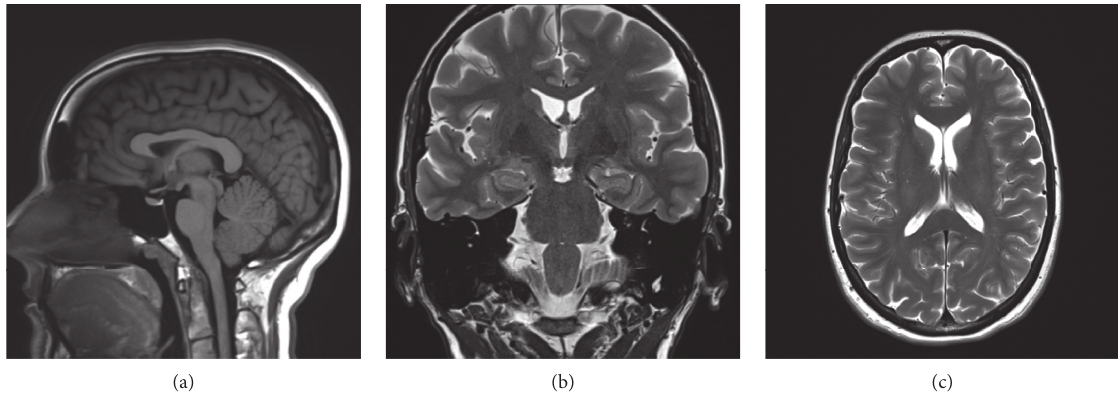
Figure 1: Brain MRI scans (512 × 512). (a) Patient 30: sagittal T1 of a 30-years-old female patient [23]. (b) Patient 50: coronal T2 of a 50-year-old female patient [24]. (c) Patient 55: axial T2 of a 55-year-old patient [25].